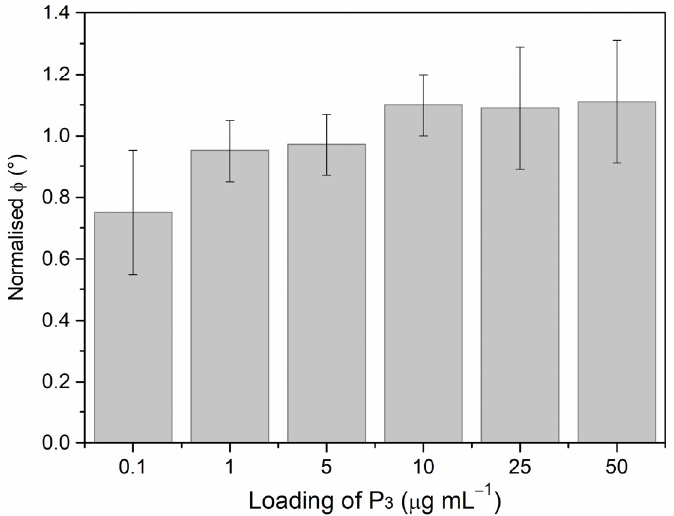
Figure 5. Comparison of the response of the SPCE platform loaded with different concentrations of P 3 ranging from 0.10 to 50 µ g mL − 1 . A buffer solution spiked with 0.1 µ g mL − 1 h-uPA was analyzed. The normalized phase value presented was calculated from the Bode plots. The error bars were obtained on the triplicates.